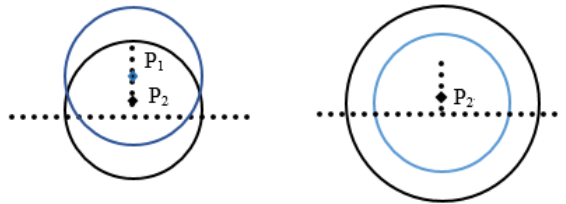
Figure 6. Eigenvalue changing in different location. (a) Sphere center is different. (b) Sphere radius is different.